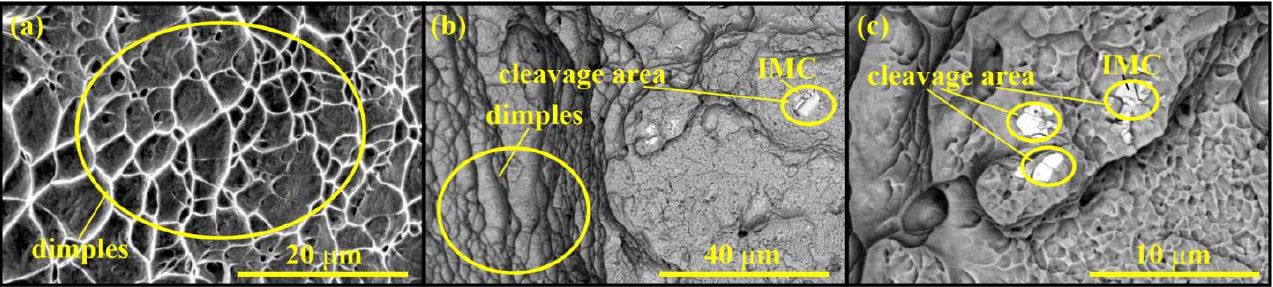
Figure 7. SE/BSE images and results of fractography analysis of the Ti-4Al-3Mo-1V weld, which was destroyed in the stir zone at different zoom levels ( a, b, c ).